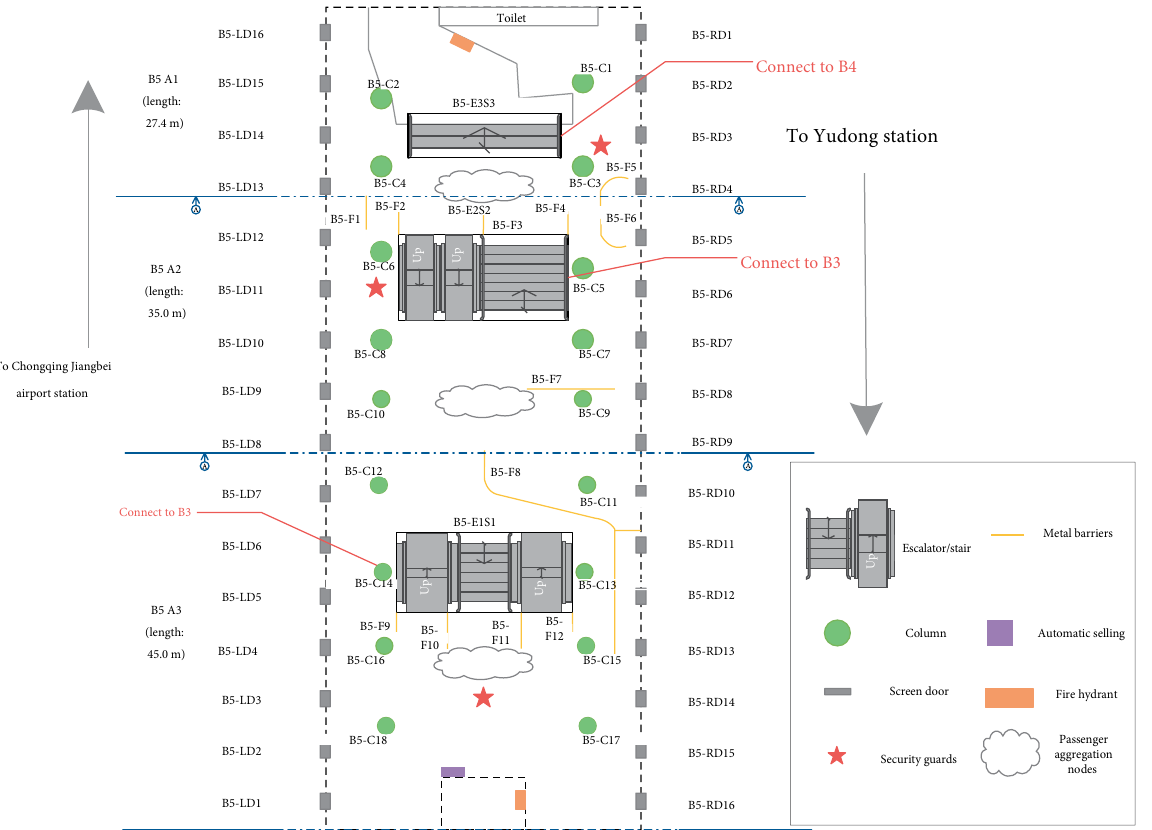
Figure 2: Layout of B5 floor (source: plotted by